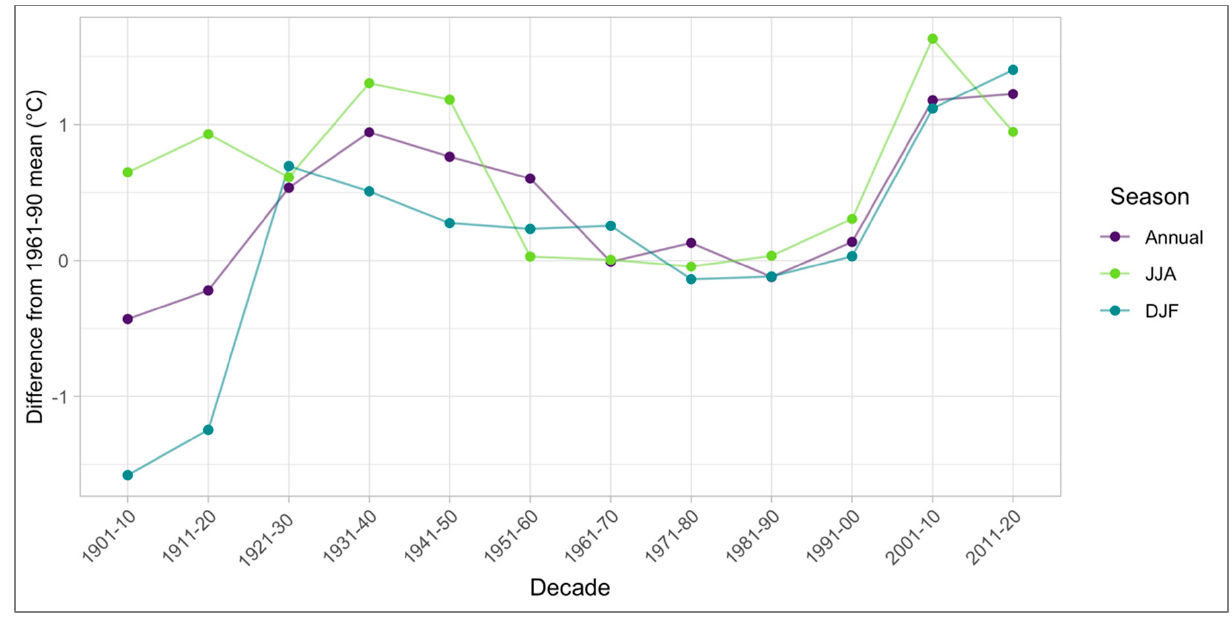
Figure 3. Temperature anomalies for each decade, 1901–2020, in Bolungarvík (JJA = June, July, August; DJF = December, January, February).